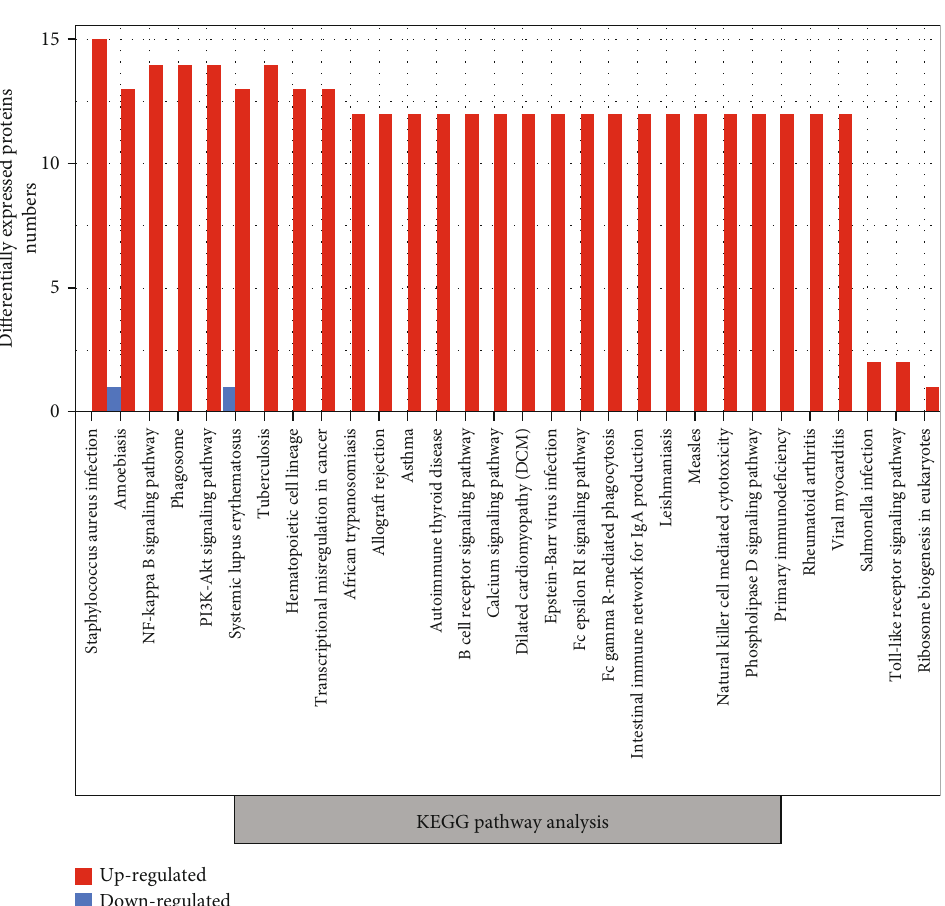
Figure 3: Network interaction diagram of di ff erentially expressed exosomal proteins of rheumatoid arthritis patients compared with STRING Protein Library. ∗ Red circle: upregulated proteins. Blue circle: downregulated proteins. The size of the circle indicates the intensity of relationship. Details for abbreviated protein names are shown in Tables 2 and 3.